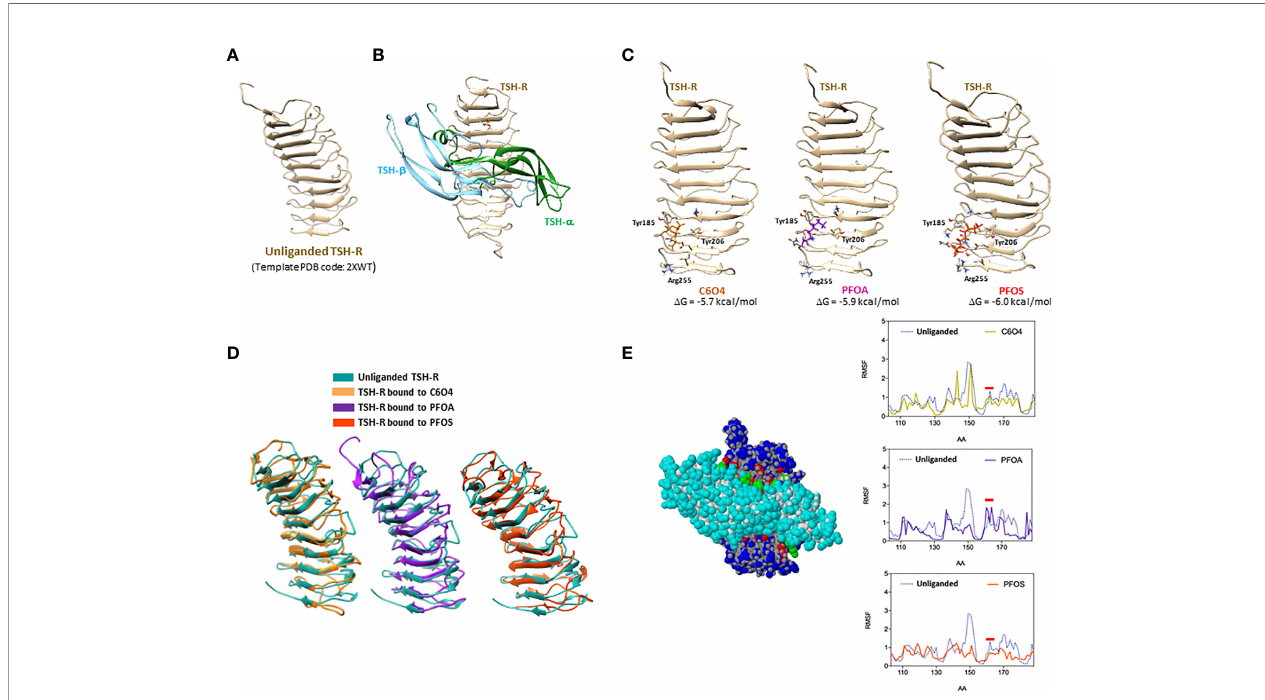
FIGURE 2 | Computer-based Molecular Docking and Molecular Dynamics Analysis of the possible docking of 2,2-di fl uoro-2-((2,2,4,5-tetra fl uoro-5(tri fl uoromethoxy)- 1,3-dioxolan-4-yl)oxy)-ammonium salt (1:1) (C6O4), per fl uoro-octanoic acid (PFOA) or per fl uoro-octane sulphonic acid (PFOS), to thyroid stimulating hormone- receptor (TSH-R), whose extracellular domain is shown in (A) . Representative model of thyroid stimulating hormone (TSH) eterodimeric chain (TSH- a and TSH- b ) bound to TSH-R is reported in (B) . Possible binding sites of C6O4, PFOA or PFOS to TSH-R are reported in (C) , with the the corresponding free Gibbs energy variations ( D G) of the complex formation and aminoacids involved in the binding. Representative images of the best conformers of unliganded receptor (blue) overimposed with the receptor bound to C6O4 (ocra), PFOA (purple) or PFOS (orange), are shown in (D) . The interaction interface between TSH and the extracellular domain of TSH-R and the the root-mean-square deviation (RMSD) pro fi le of the LEU100-GLN170 domain of the receptor, mainly involved in the binding to TSH, of unliganded receptor and the receptor bound to C6O4, PFOA, or PFOS, are shown in (E)